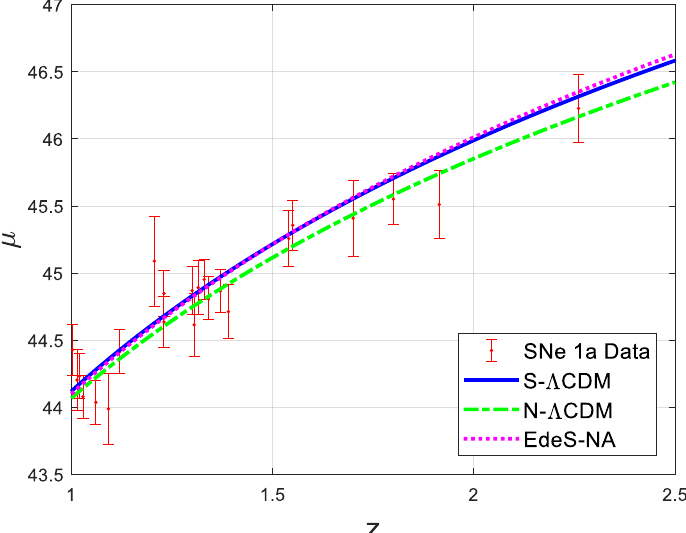
Figure 2. Data fit for 1.0 < 𝑧 < 2.5 based on models parameterized using 𝑧 < 1.0 data.